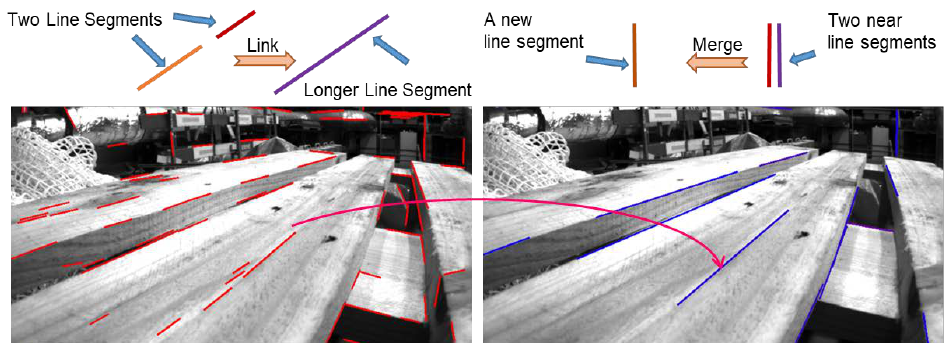
Figure 7. We link line segments into a longer one, and merge near line segments into a new one to enhance the quality of lines extracted by LSD. The image comes from EuRoC dataset sequence MH_01_easy.